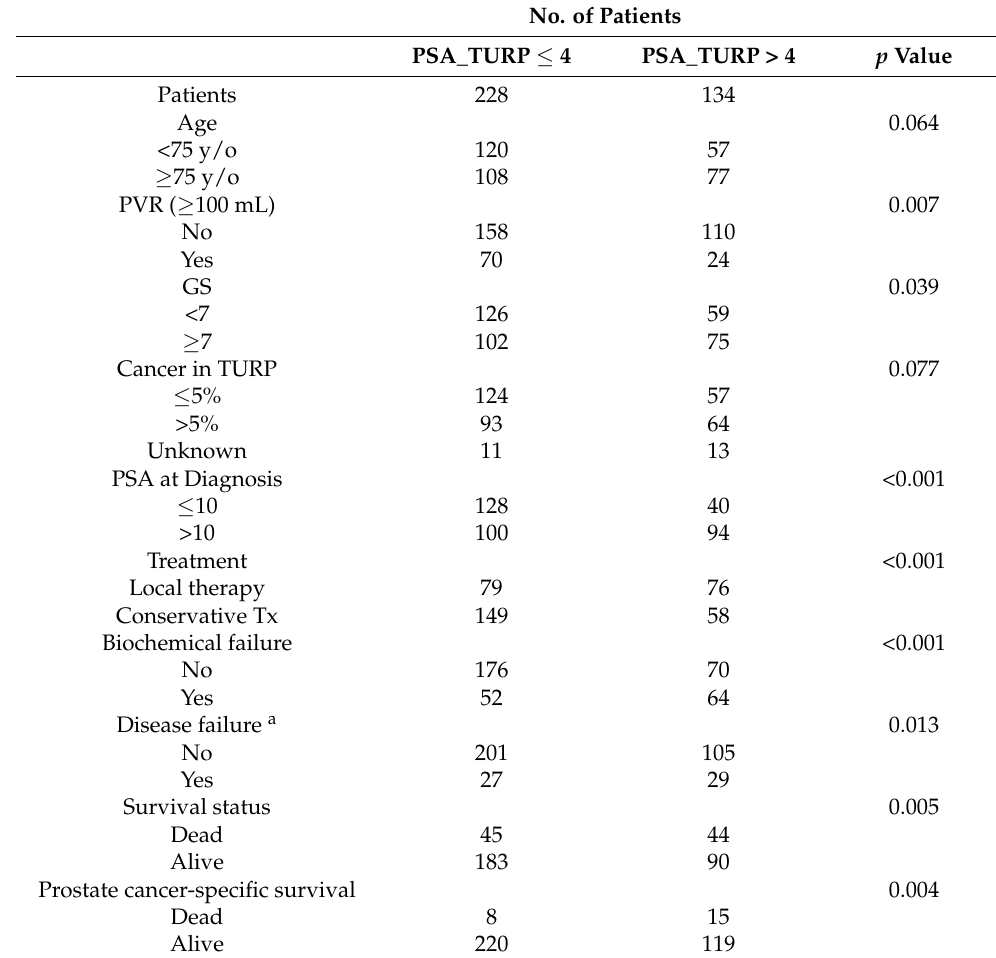
Table 2. Characteristics of 362 T1-2N0M0 patients who underwent TURP at diagnosis and recheck PSA after TURP at diagnosis. No. of Patients PSA_TURP ≤ 4 PSA_TURP >